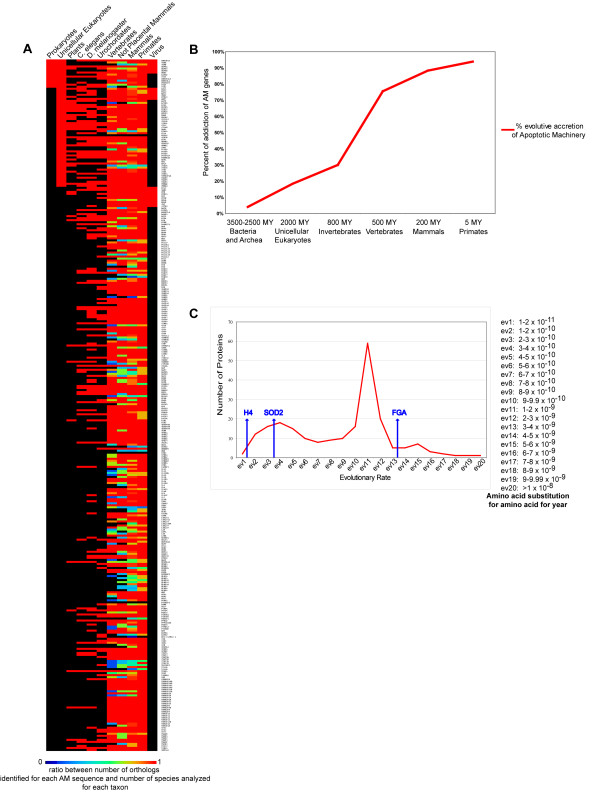
AM evolution. Panel A. Matrix of phylogenetic distribution of AM genes in all taxa. Each row represents the color coded ratio between ortholog number for individual AM genes and species analyzed in a given taxon, according to the colour bar shown above the matrix; the columns represent the taxa. Panel B. Evolutionary accretion of AM: number of AM genes appeared in the genomes during evolution. Panel C. Evolutionary rate of AM proteins: the X-axis represents the distribution classes of evolutionary rates, indicated as amino acid substitution for 100 amino acids per year as shown in the caption to the right. The Y-axis represents the number of proteins in each class of evolutionary rate.